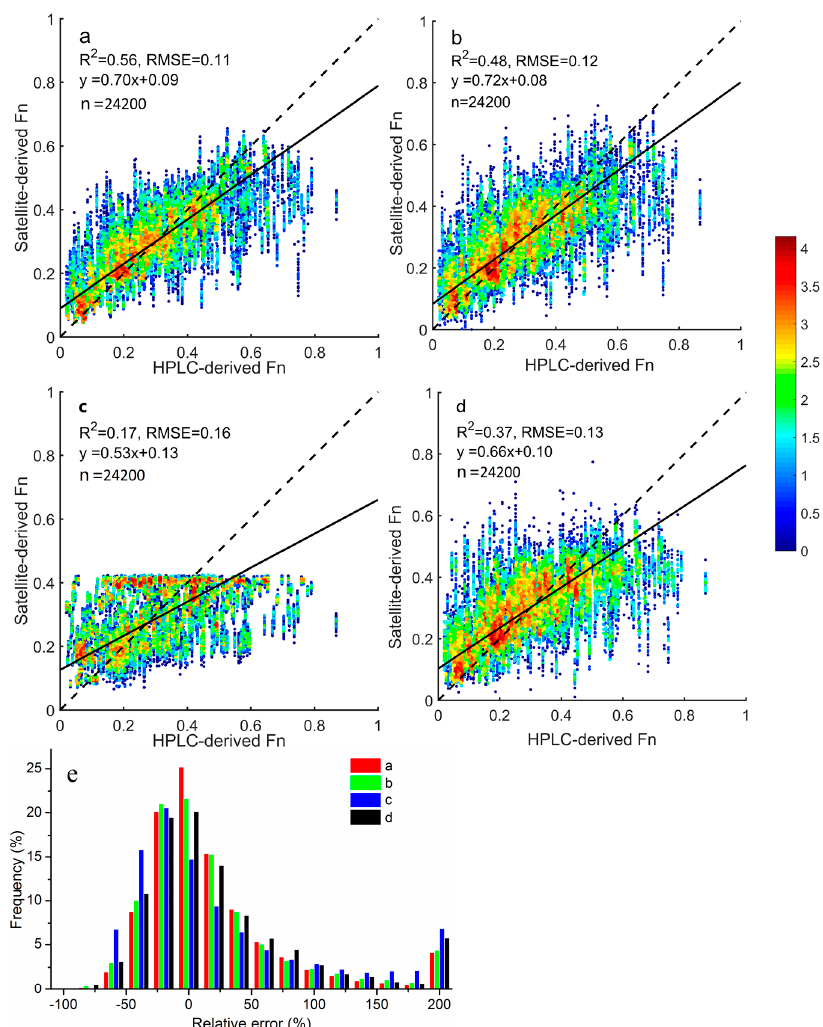
Figure 3. Scatter plots of satellite-derived versus high performance liquid chromatography (HPLC) nanoplankton size fractions (Fn): ( a ) random forests using features selected with SVM-RFE, ( b ) SVM using features selected with SVM-RFE, ( c ) SVM using ocean color features selected with SVM-RFE, and ( d ) three-component method. The dashed line is a 1:1 line, and the solid is a regression line. Plot ( e ) shows the frequency distributions of their relative errors, and the numbers along the color ramp indicates the pixel density after log transformation (y = ln(x)).